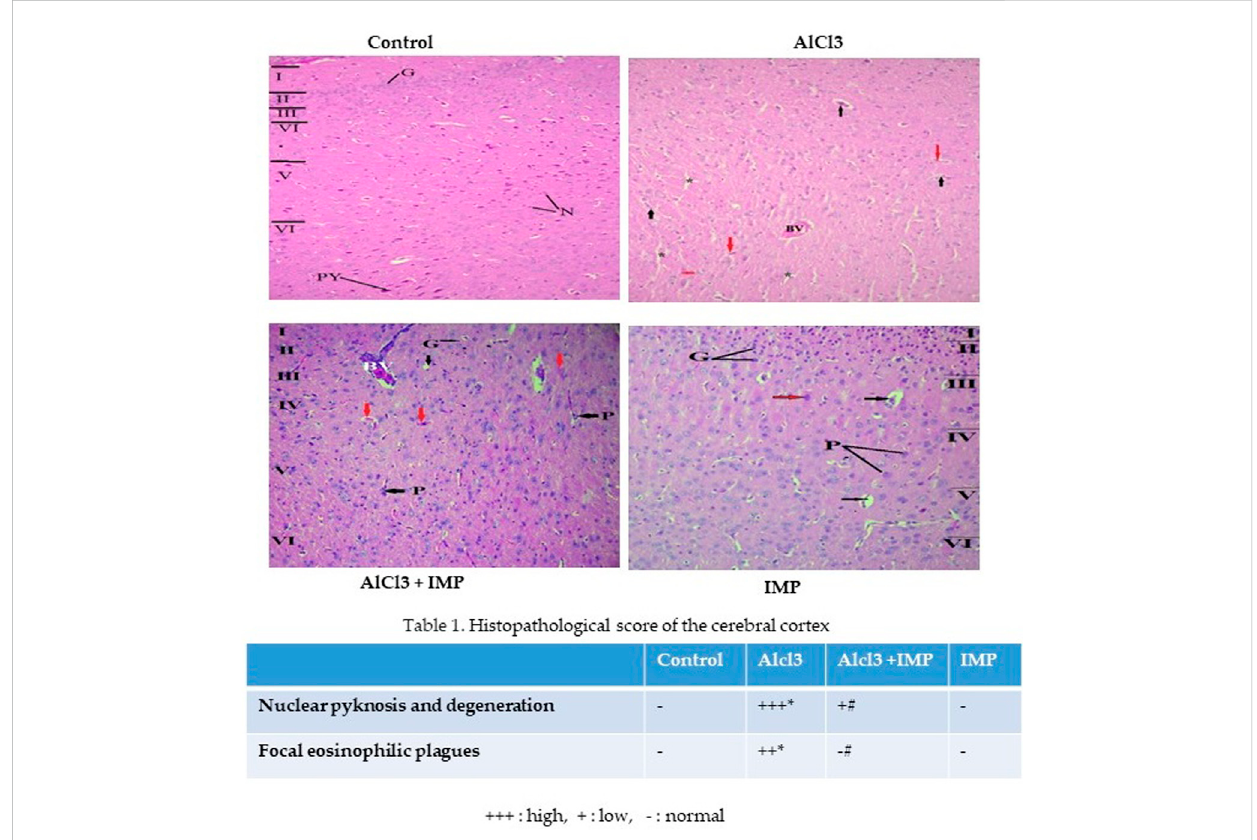
FIGURE 8 Histopathological analysis of brain tissue. The difference between the treatment and control groups was statistically signi fi cant; * p < 0.05, # p < 0.05wasconsideredstatisticallysigni fi cant.Valuesareexpressedasmean±SD, n =3.* p < 0.05indicatessigni fi cantdifferencesbetweentheAlCl3-alone group and the control group. # p < 0.05 shows signi fi cant differences between AlCl3 alone and IMP with